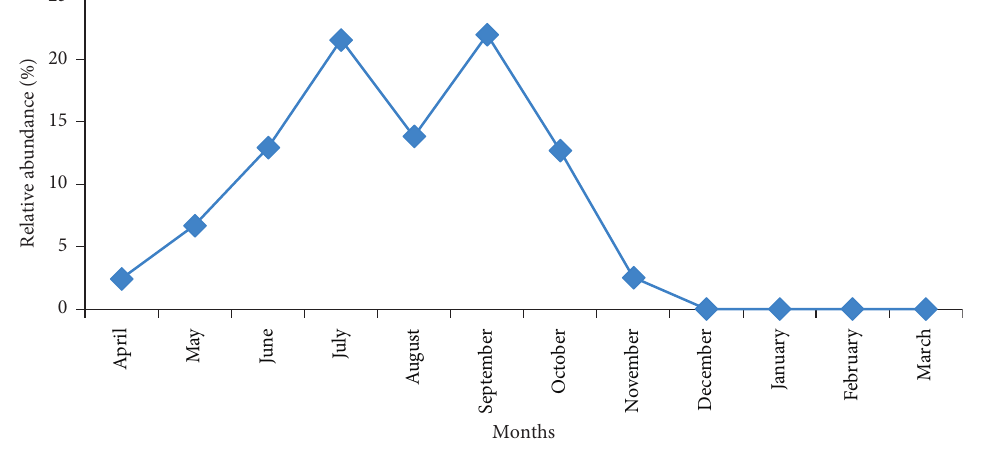
Figure 2: Seasonal fluctuation of sandflies.